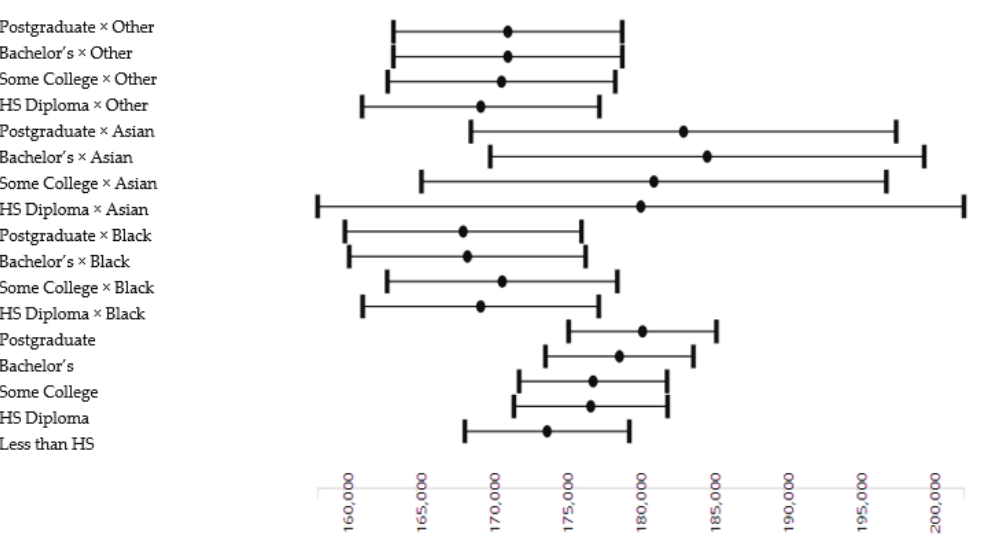
Figure 3. E ff ects of parental education on the whole-brain cortical surface area by